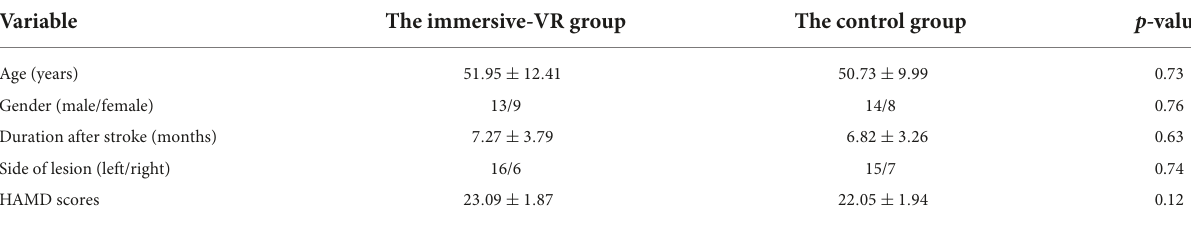
TABLE 1 Demographic and clinical characteristics.